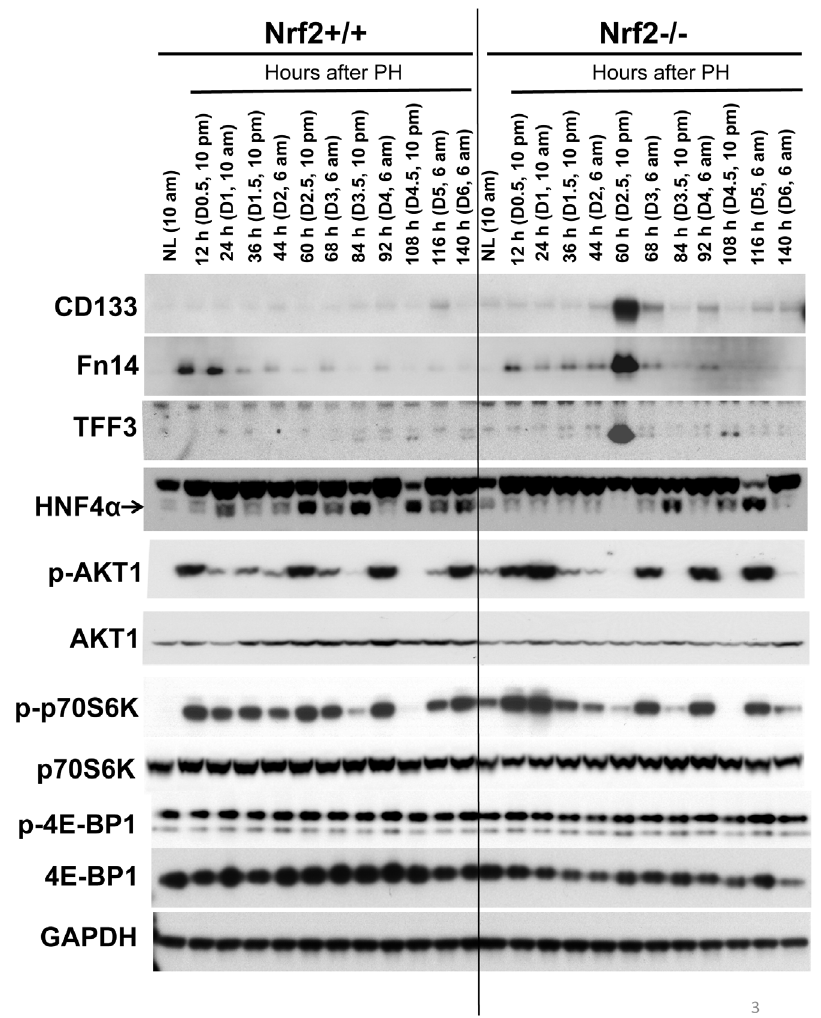
Figure 3. Protein expression of CD133, Fn14, TFF3, HNF4 a , p-Akt1 (T308), Akt1, p-p70S6K (T389), p70S6K, p-4E-BP1 (T37/46), and 4E-BP1 in regenerating livers of Nrf2 + / + and Nrf2 2 / 2 mice. Livers were collected from normal mice and the mice subjected to partial hepatectomy (PH) at the indicated time points following surgery. Liver lysates prepared from three mice per time point per genotype were pooled with equal amount of protein from each preparation. Western blotting was performed with antibodies against the proteins indicated. Glyceraldehyde 3-phosphate dehydrogenase (GADPH) was used as a loading control. NL, normal liver.